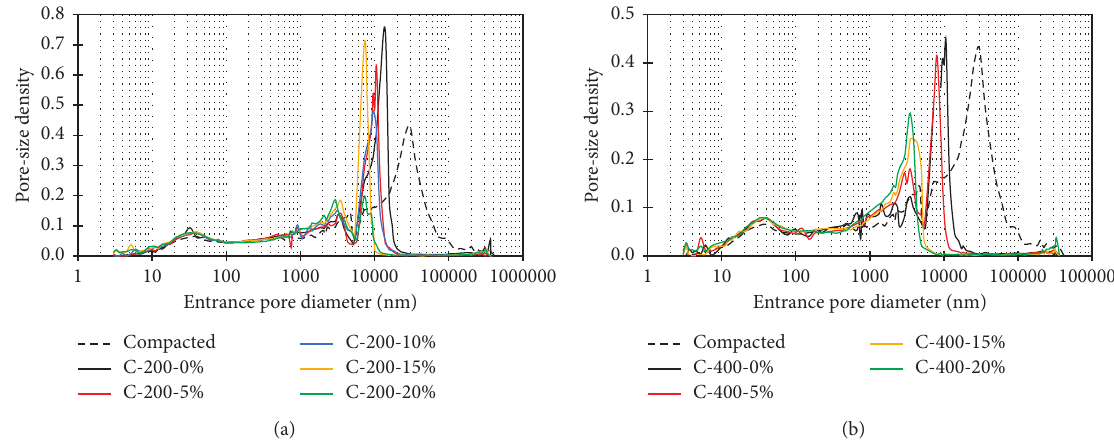
Figure 12: PSDs of compacted loess specimens sheared to sequential axial strains under the confining stress of (a) 200 kPa and (b) 400kPa.